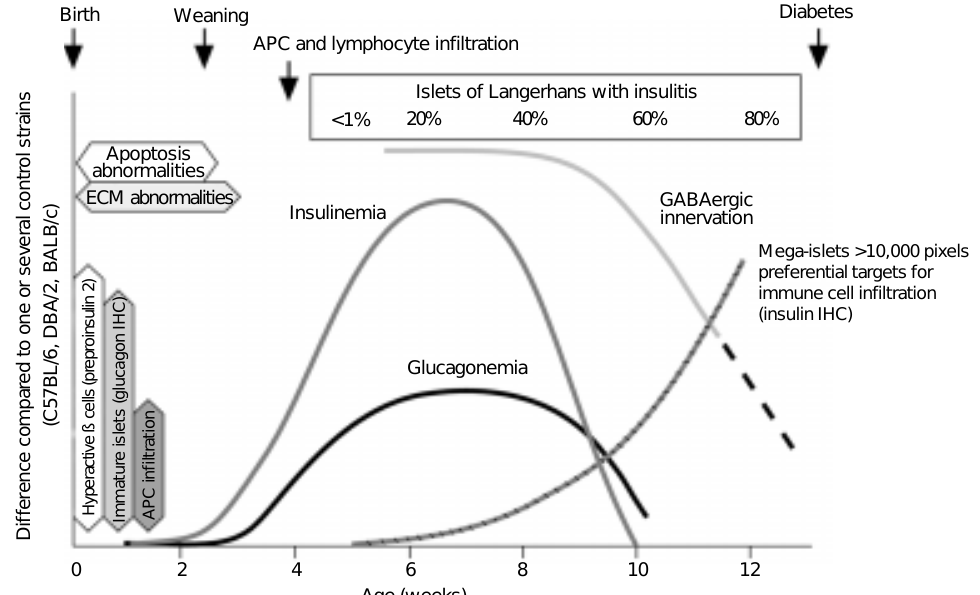
Figure 1 - Kinetics of abnormali- ties observed at the pancreas level in prediabetic female NOD mice. APC: Antigen-presenting cells; ECM: extracellular matrix; GABA: gamma-aminobutyric acid; IHC: immunohistochemis-